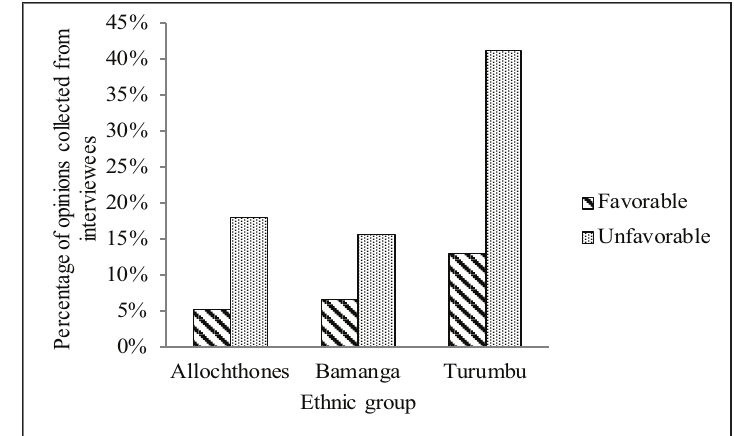
Figure 7. Opinion of interviewees on the management of Yangambi Biosphere